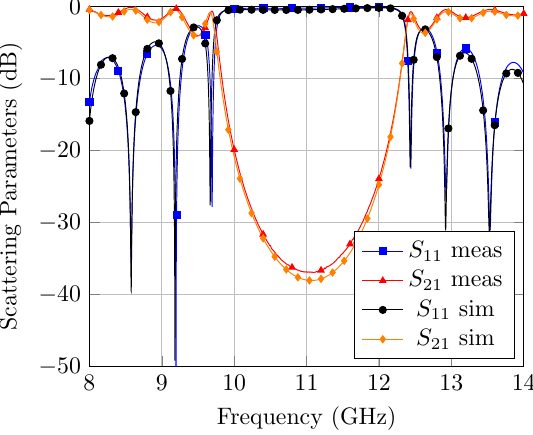
Figure 9. Simulated and measured scattering parameters of the manufactured ESICL filter